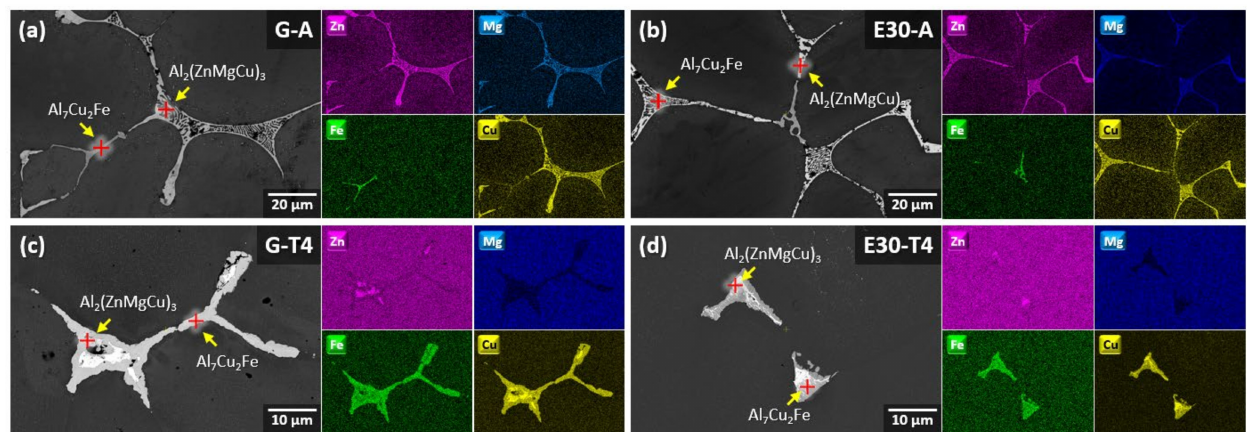
Figure 2. Precipitation analysis of as-cast and heat-treated specimens in Al-Zn-Mg-Cu alloys using back-scattered elec-tron (BSE) micrographs and EDS elemental mapping. Al 7 Cu 2 Fe and Al 2 (ZnMgCu) 3 phases presented in ( a ) G-A and ( b ) E30-A specimens. Al 7 Cu 2 Fe phase and Al 2 (ZnMgCu) present in ( c ) G-T4 and ( d ) E30-T4 specimens. (Red X sign and yellow arrow are indicating the EDS point analysis of secondary phases presented in Table